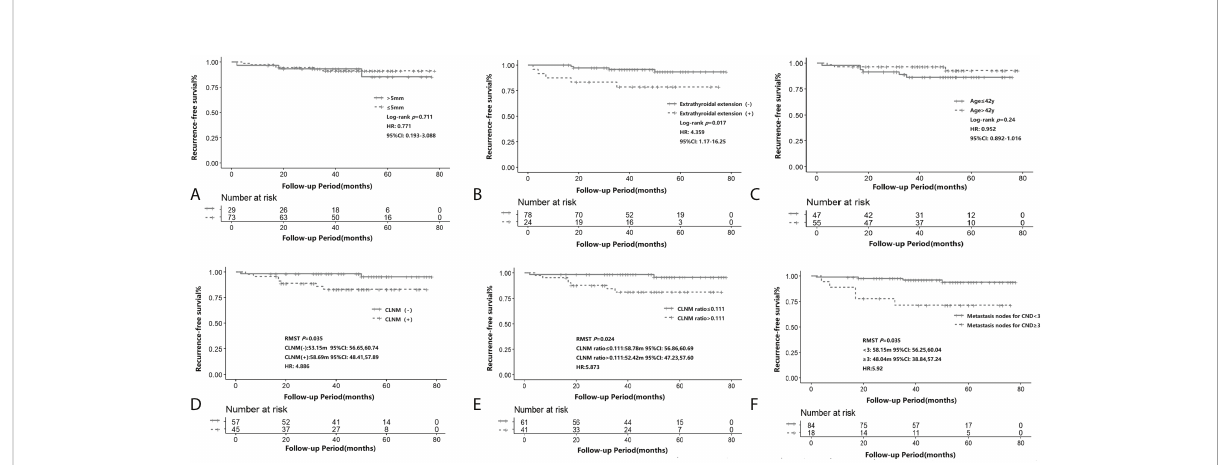
FIGURE 2 Recurrence-free survival according to tumor size ( ≤ 5 mm and >5mm) (A) , presence of extrathyroidal extension (B) , age ( ≤ 42y and >42y) (C) , CLNM (D) , CLNM ratio ( ≤ 0.111 and >0.111) (E) and the number of metastatic lymph nodes (> 2 and ≤ 2) (F) in iPTMC. The Kaplan – Meier method for recurrence with the log-rank test was used for statistical comparisons of A-C . The restricted mean survival time (RMST) was used for survival analysis of D-F . CLNM, central lymph node metastasis.